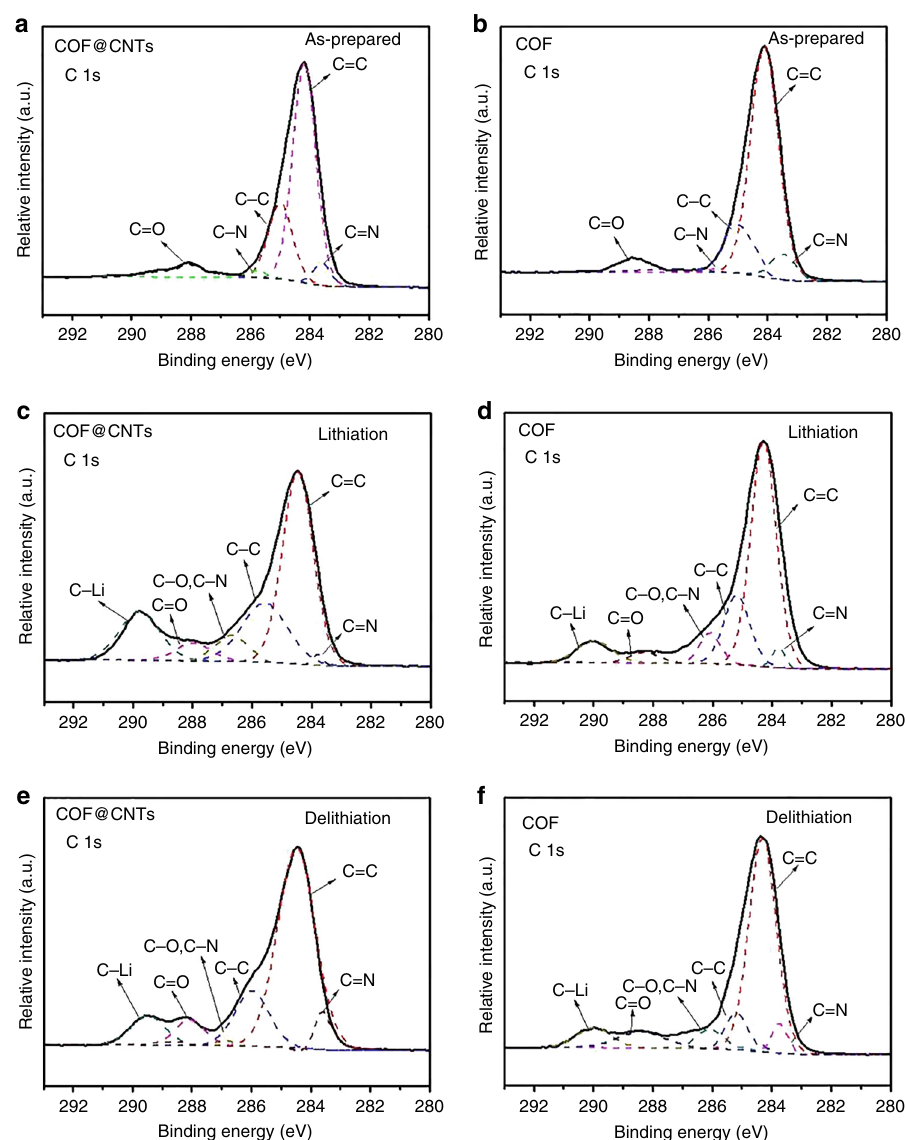
Fig. 5 XPS results for COF@CNTs and COF. a C 1s scan of as-prepared COF@CNTs, b C 1s scan of as-prepared COF, c C 1s scan of COF@CNTs after lithiation process, d C 1s scan of COF after lithiation process, e C 1s scan of COF@CNTs after delithiation process, and f C 1s scan of COF after delithiation process